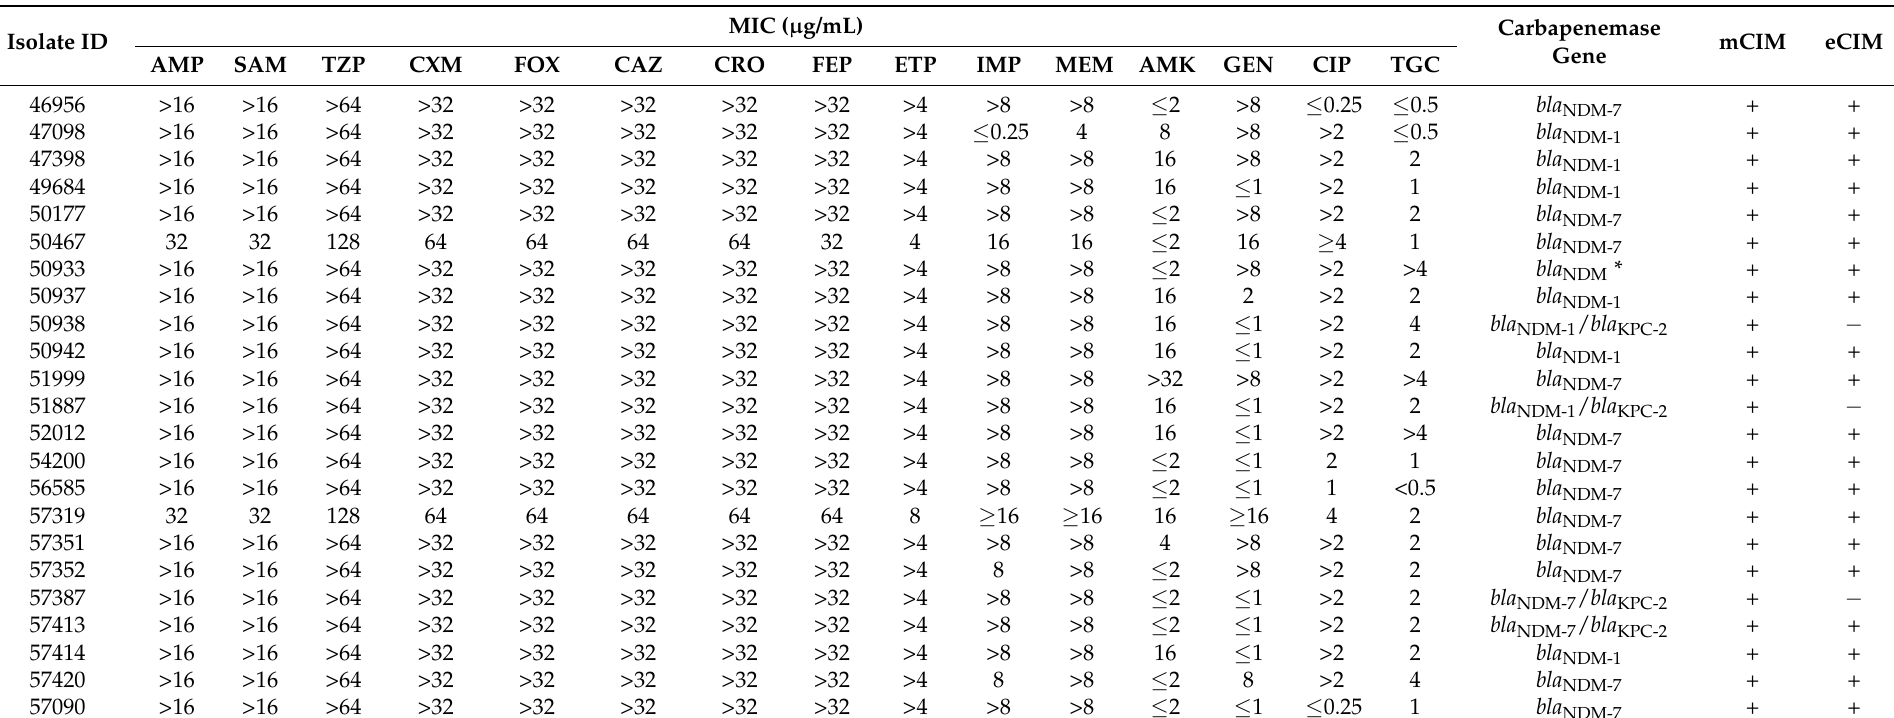
Table 2. Phenotypical and molecular susceptibility features of MDR K. pneumoniae isolates from different healthcare institutions, state of Par á , Brazilian Amazon